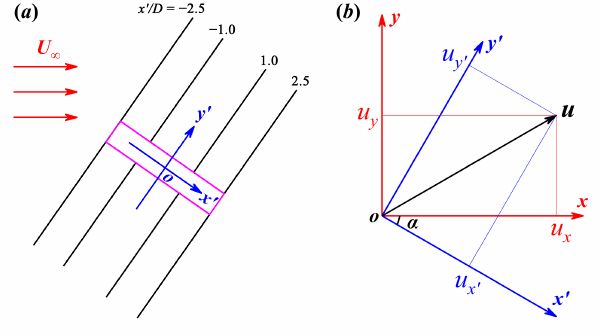
Figure 13. Schematic diagram of ( a ) cross-section distribution and ( b ) velocity decomposition (red is the global coordinate system, and blue is the local coordinate